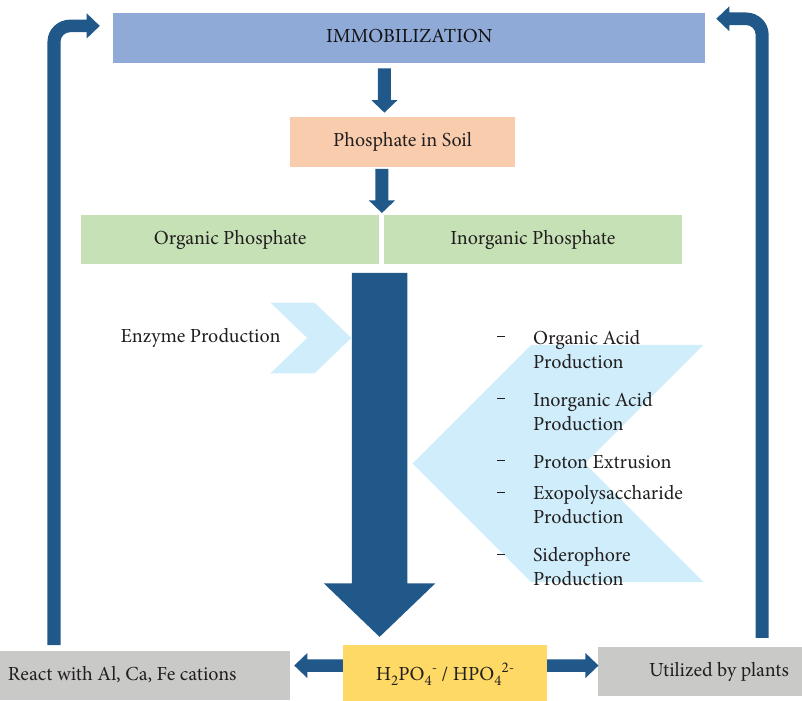
Figure 1: Phosphate solubilizing mechanisms of